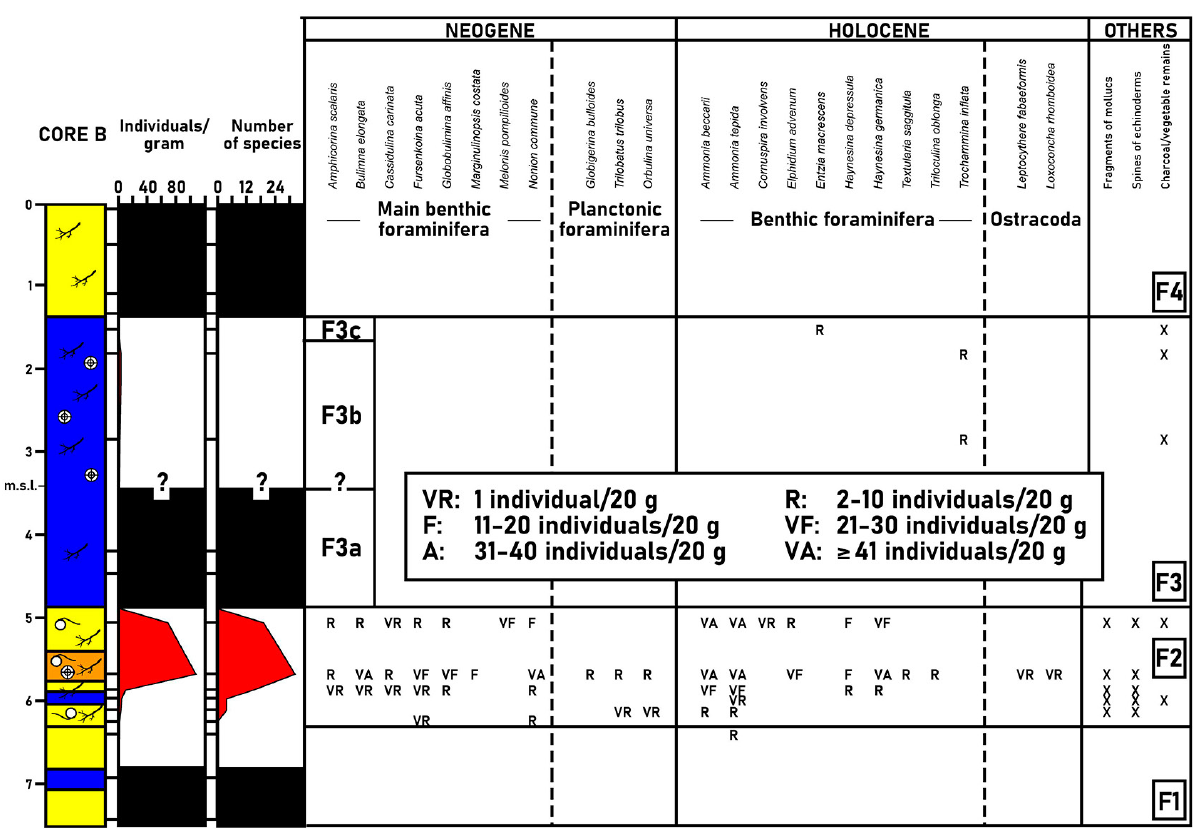
Fig. 4. – Palaeontological record of core